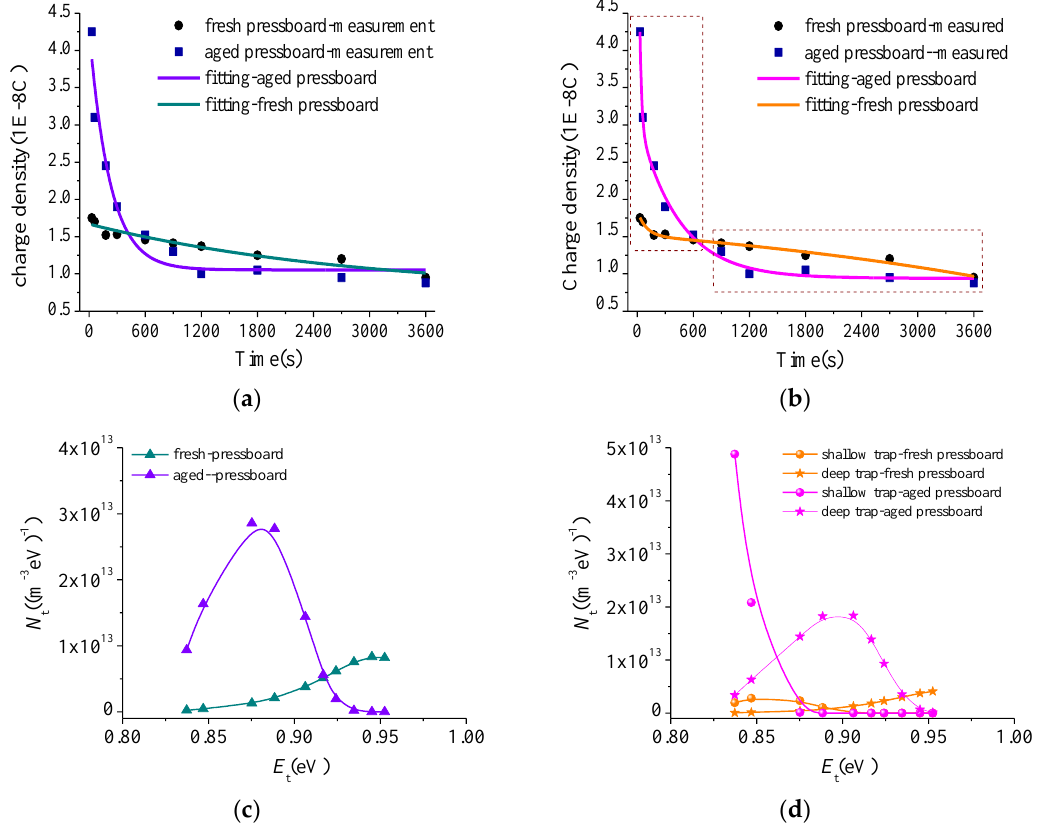
Figure 9. Charges decay and trap distribution analysis for the fresh and aged oil impregnated insulation pressboard sample applied negative 25 kV/mm voltage for 4 h (charges data was derived from [38]). ( a ) common method: charge decay analysis; ( b ) new method: charge decay analysis; ( c ) common method: charge decay analysis; ( d ) new method: charge decay analysis. Table 4. The charge detrapping expression for the fresh and aged oil impregnated insulation pressboard sample applied negative 25 kV/mm voltage for 4 h (charges data was derived from [38]).